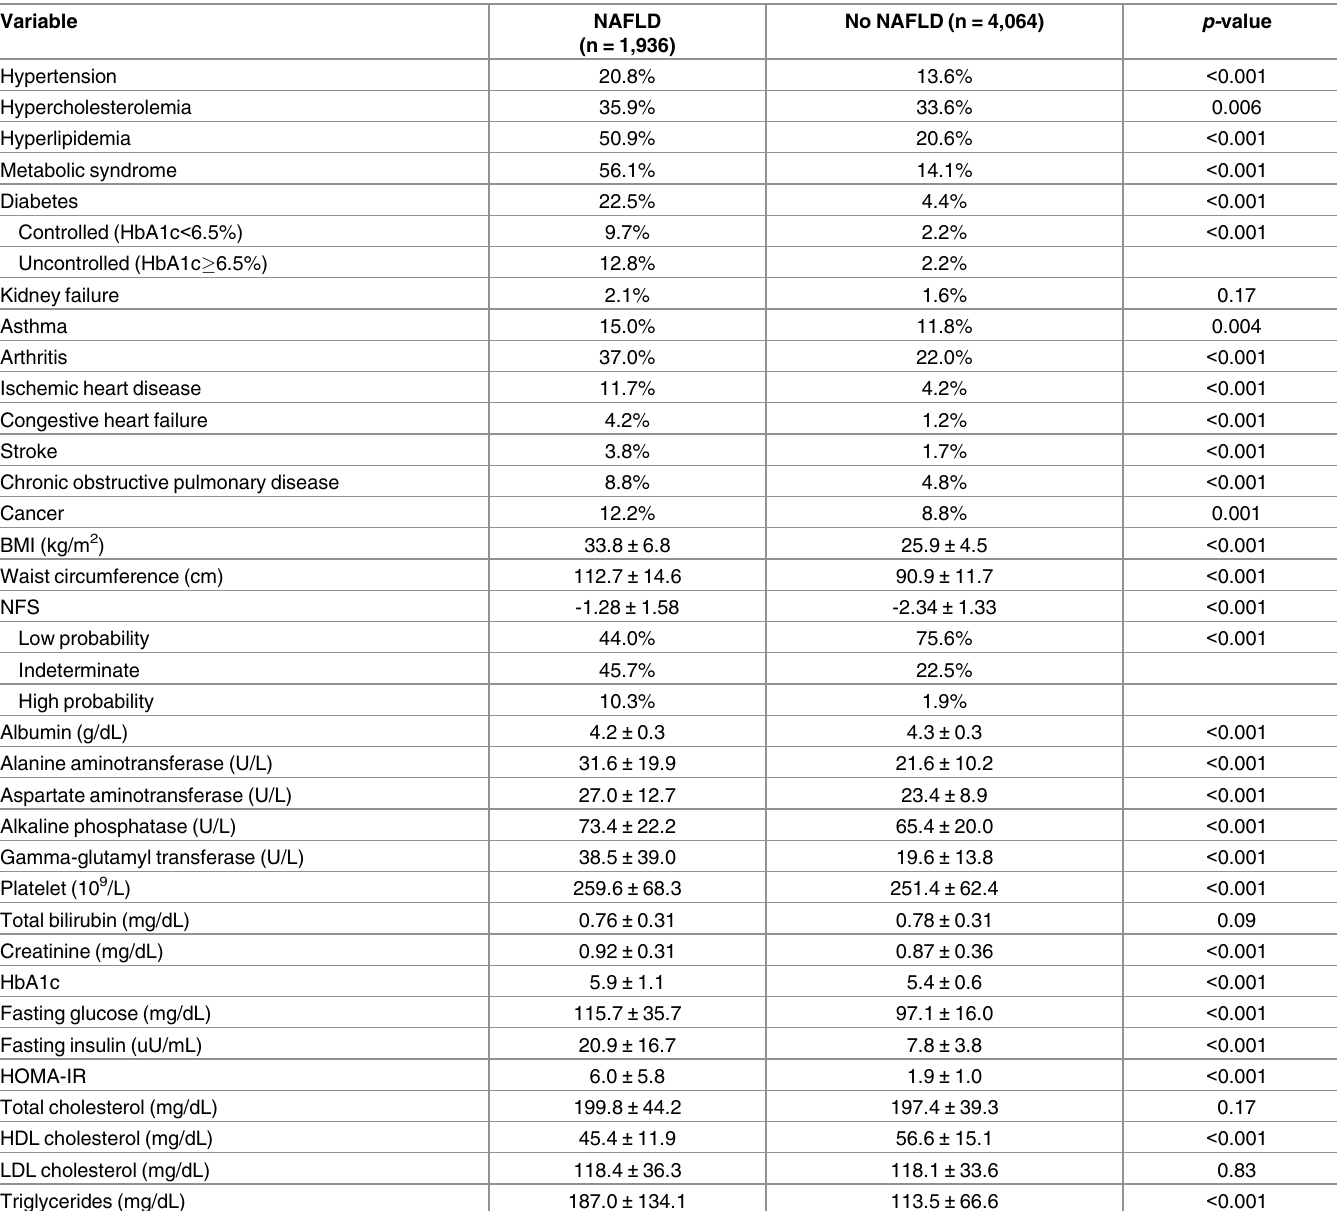
Table 2. Lab and clinical characteristics of participants by NAFLD status in the U.S. National Health and Nutrition Examination Survey,